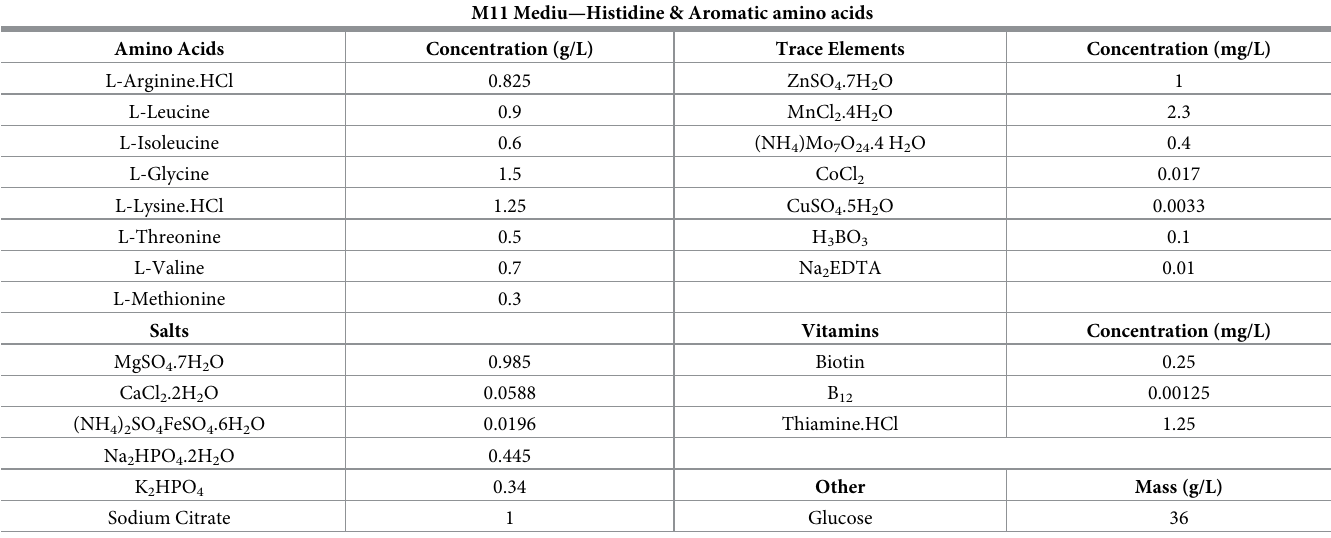
Table 1. Composition of histidine deficient modified M11 medium per